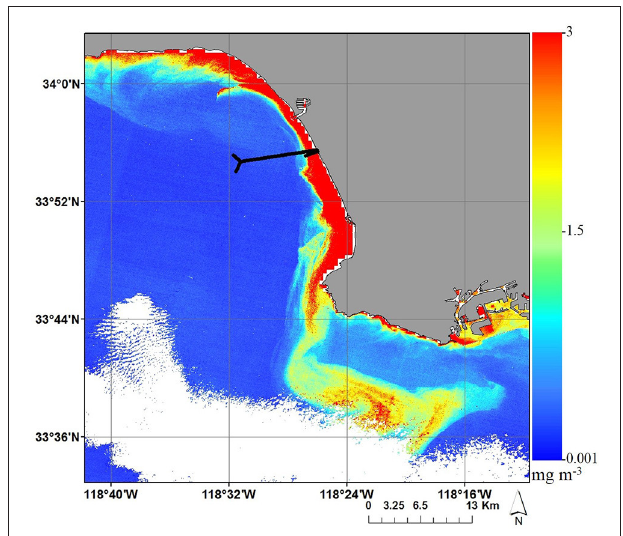
FIGURE 8 | Larger spatial extent of chl-a distribution on 26 October 2015, using the local OLI chl-a algorithm. Elevated chl-a values were detected along the coast that continue to wrap around the peninsula to the south. A large cloud region has been masked out in the bottom of the OLI frame.